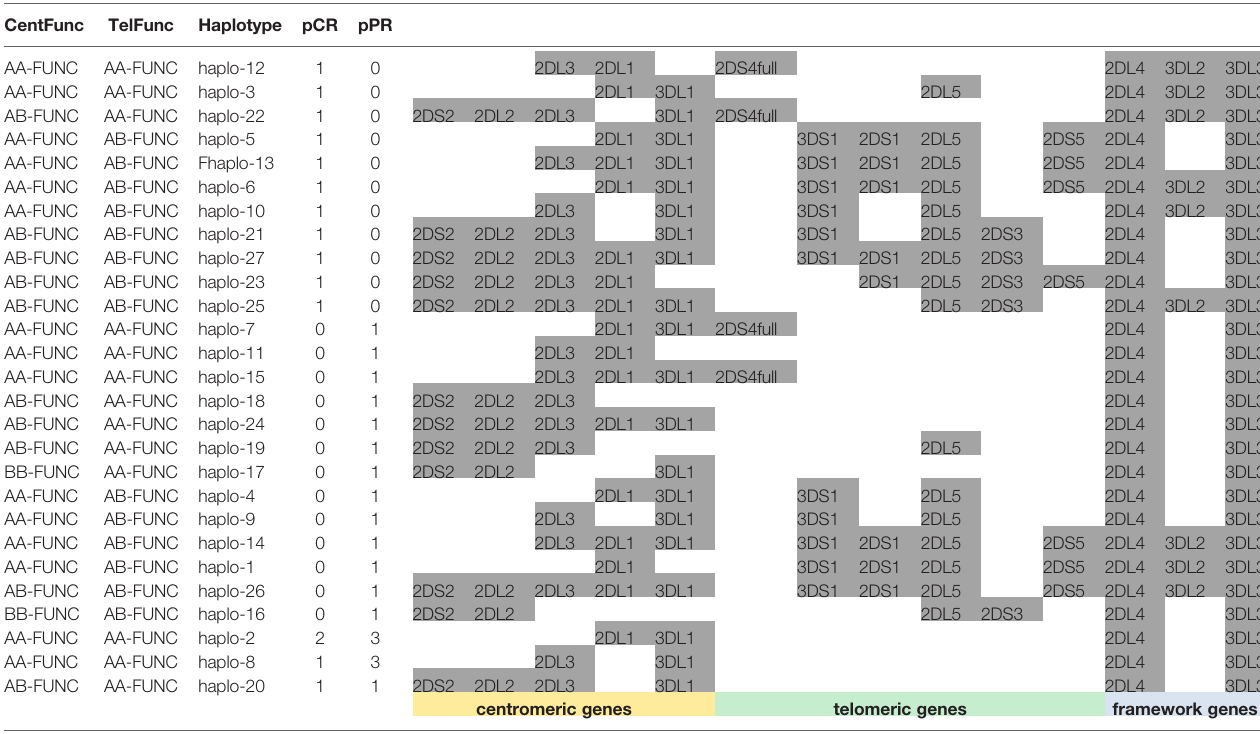
TABLE 5 | Distribution of functional KIR/HLA haplotypes between CR and PR